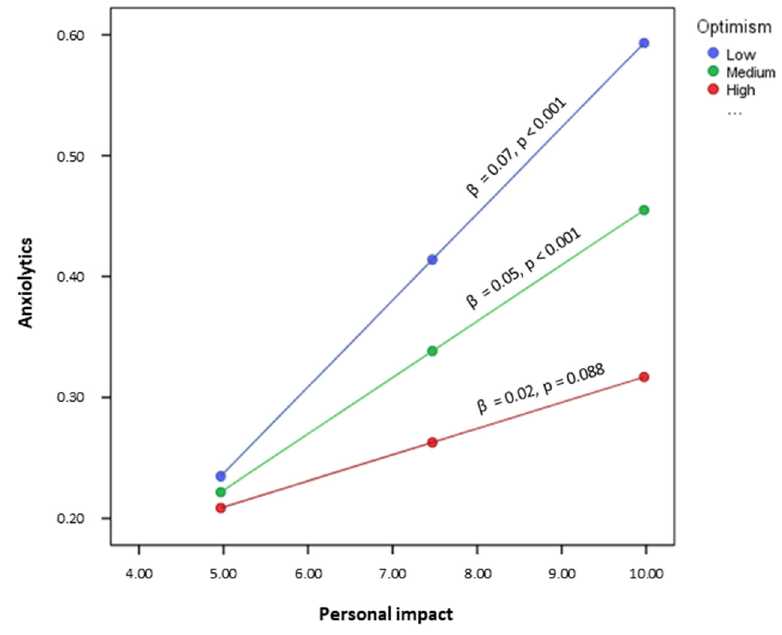
Figure 3. Interaction of “Personal Impact–Optimism” on the prediction of use of